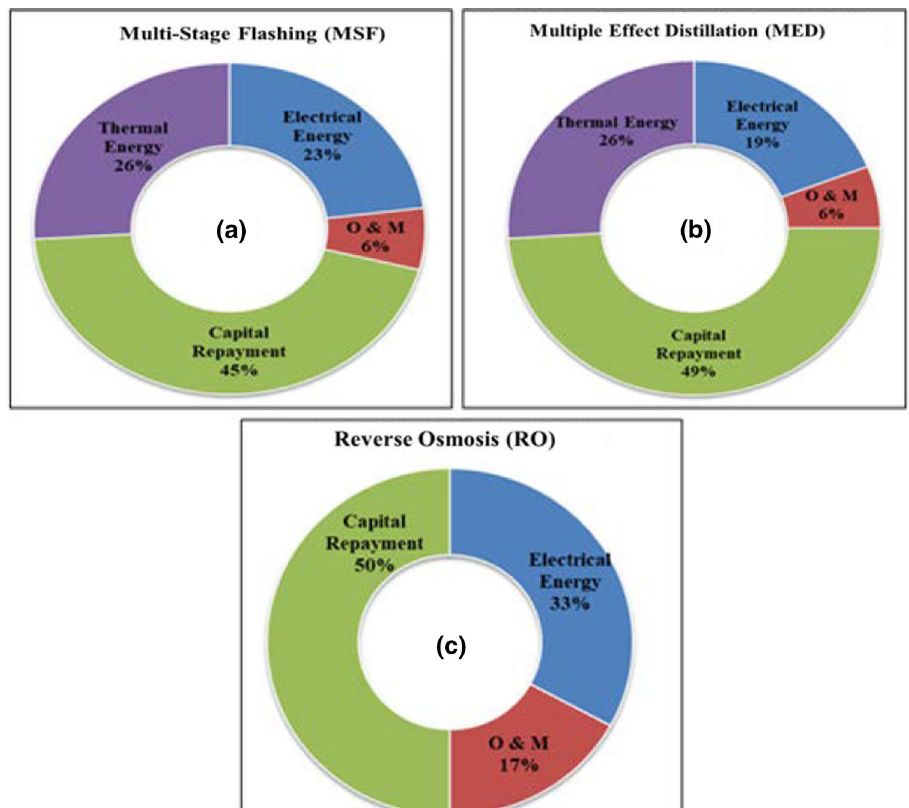
Fig. 6 Percentage of cost uti- lized in a MSF, b MED, c RO